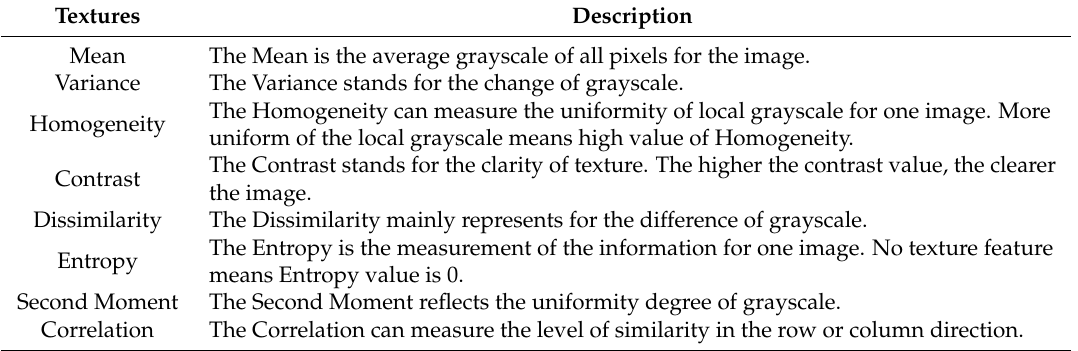
Table 1. Description of different texture features by gray level co-occurrence matrix